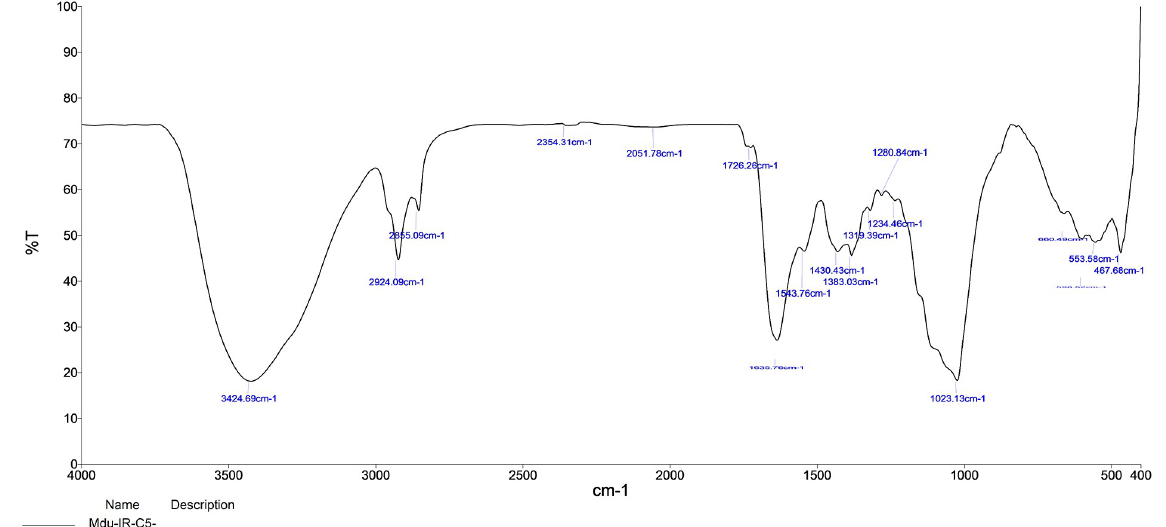
Fig 9. FTIR results showing the presence of different chemical groups in the silver